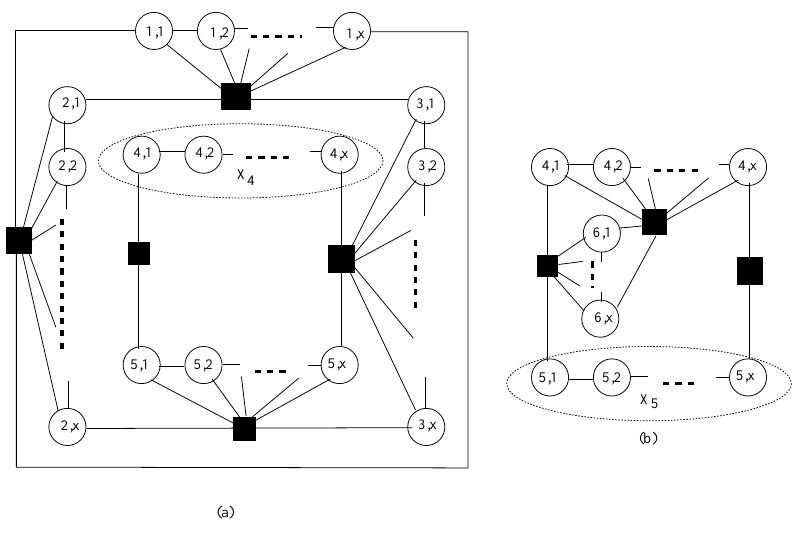
Figure 3. ( a ) Subgraph G [ U (0 , 3)] and ( b ) Subgraph G [ U (1 , 3)] of G